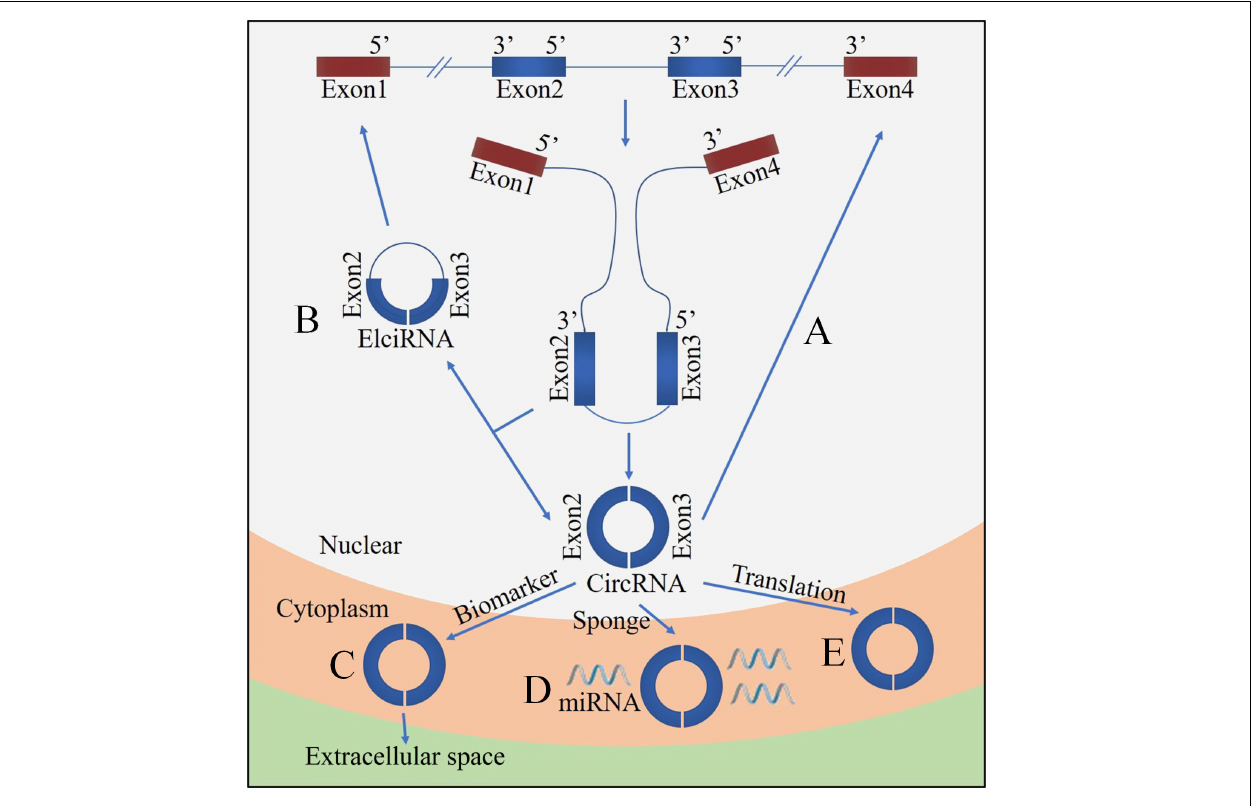
FIGURE 4 | Functions of circRNA. (A) CircRNA can compete with the canonical splice of pre-mRNAs. (B) Nuclear localized circRNA can affect gene expression via exon intron circRNA (ElciRNA). (C) CircRNAs are promising biomarkers. (D) CircRNAs can act as sponges of miRNAs. (E) CircRNAs can be